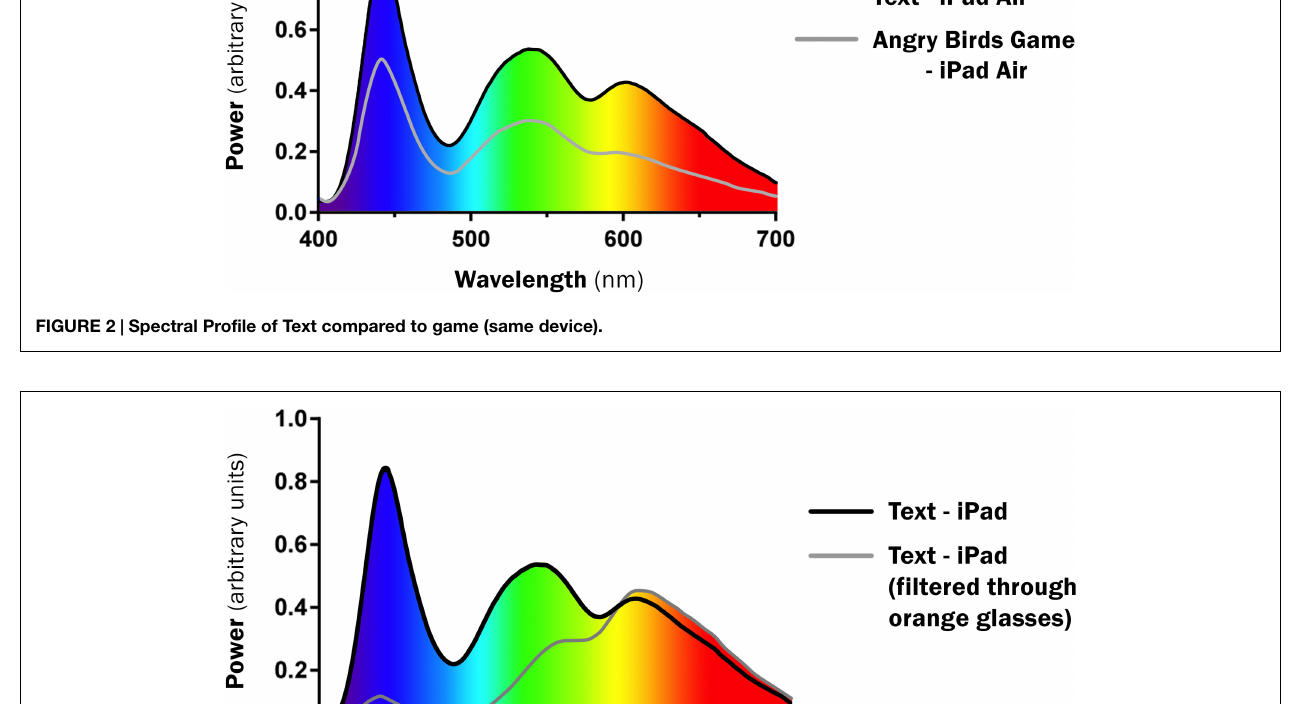
to the “text” or “Angry Birds” with a marked reduction in short-wavelength light emissions ( Figure 4